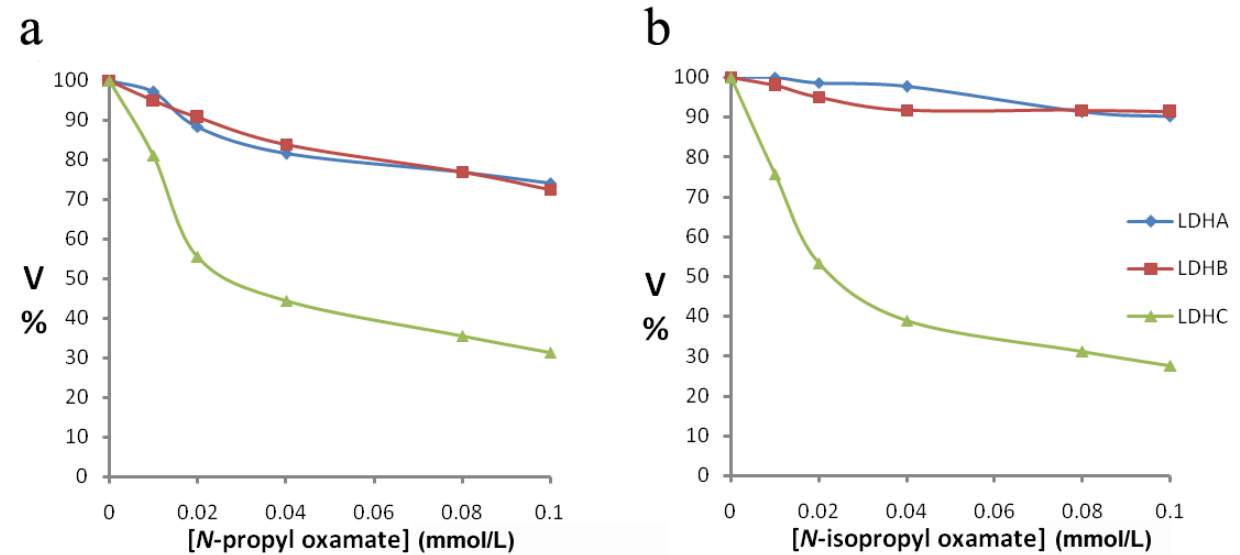
Figure 4. ( a ) Effect of increasing concentrations of N- propyloxamate and N- isopropyl oxamate on plateau pika LDH isozymes. N- propyl oxamate. ( b ) N- isopropyl oxamate. Pyruvate was used as substrate. Velocities were calculated taking the maximum activity without the N -propyl oxamate or N -isopropyl oxamateas 100%. N- propyl oxamate or N- isopropyl oxamate were added at the concentration of 0.01 mmol/L, 0.02 mmol/L, 0.04 mmol/L, 0.08 mmol/L and 0.1 mmol/L. ( ◆ ) LDH-A 4 , ( ■ ) LDH-B 4 , ( ▲ ) LDH-C 4